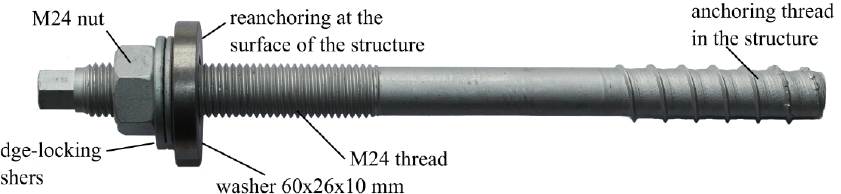
Figure 1. Concrete Screw Anchor with anchoring thread which creates a form-locked connection and the re- anchoring at the concrete surface of the structure.